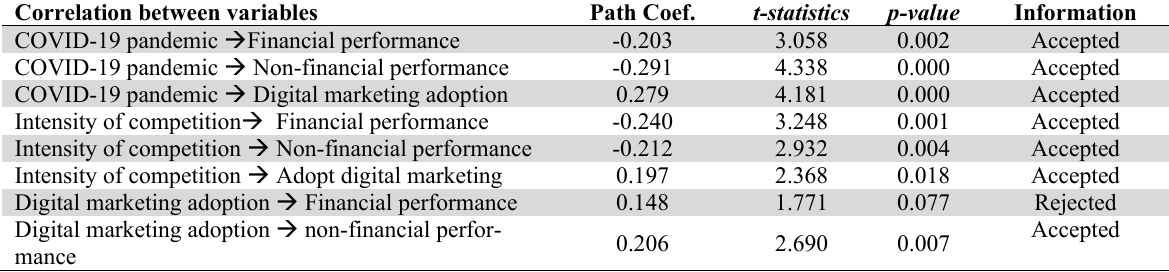
Path Coefficient Correlation between variables